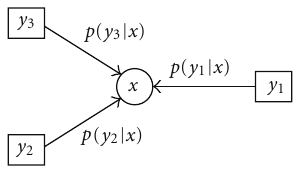
Figure 3: A symbol node connected with three observation nodes.